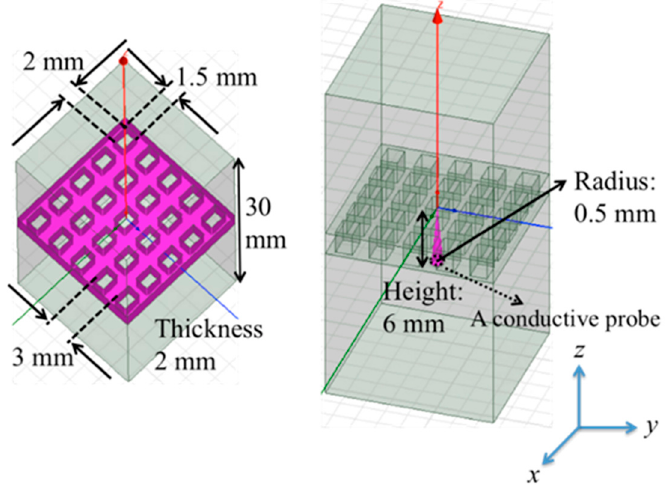
Figure 8. The two models for numerical analyses of the electric field distribution around the MHA.